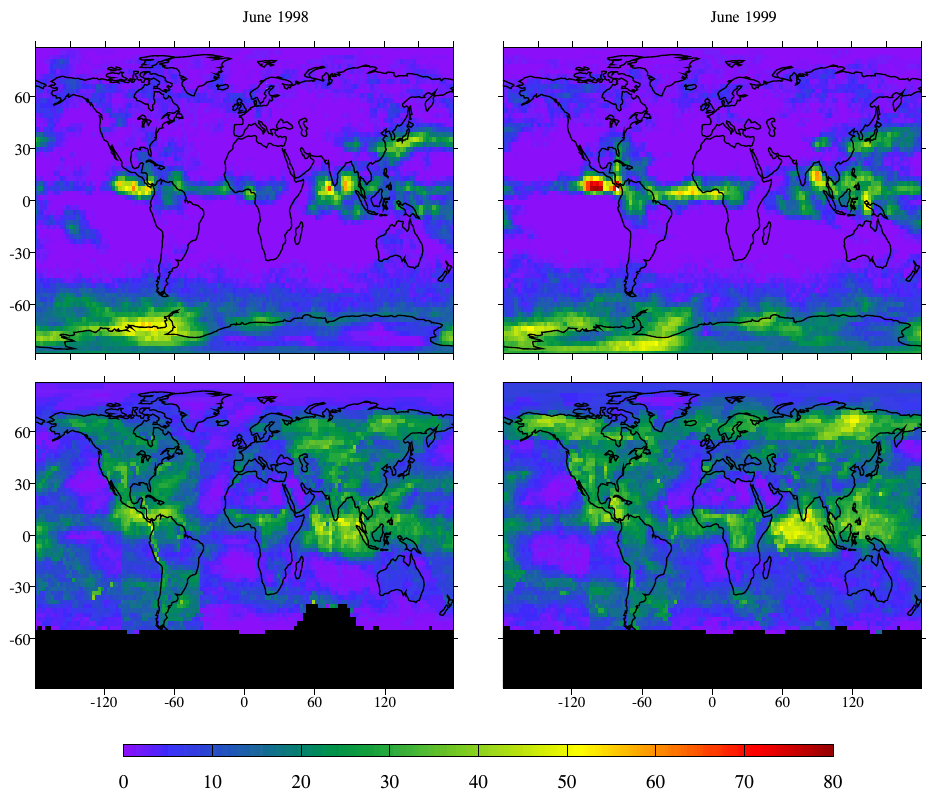
Fig. 4. Similar comparison of the frequency of occurrence of ice to those shown in Fig. 3. Again the top row is frequency of occurrence from the model and the bottom row from the ISCCP. This figure shows mean values for June 1998 (left column) and 1999 (right column). The relatively high values in the model data for the area below approximately 55 ◦ S are polar stratospheric